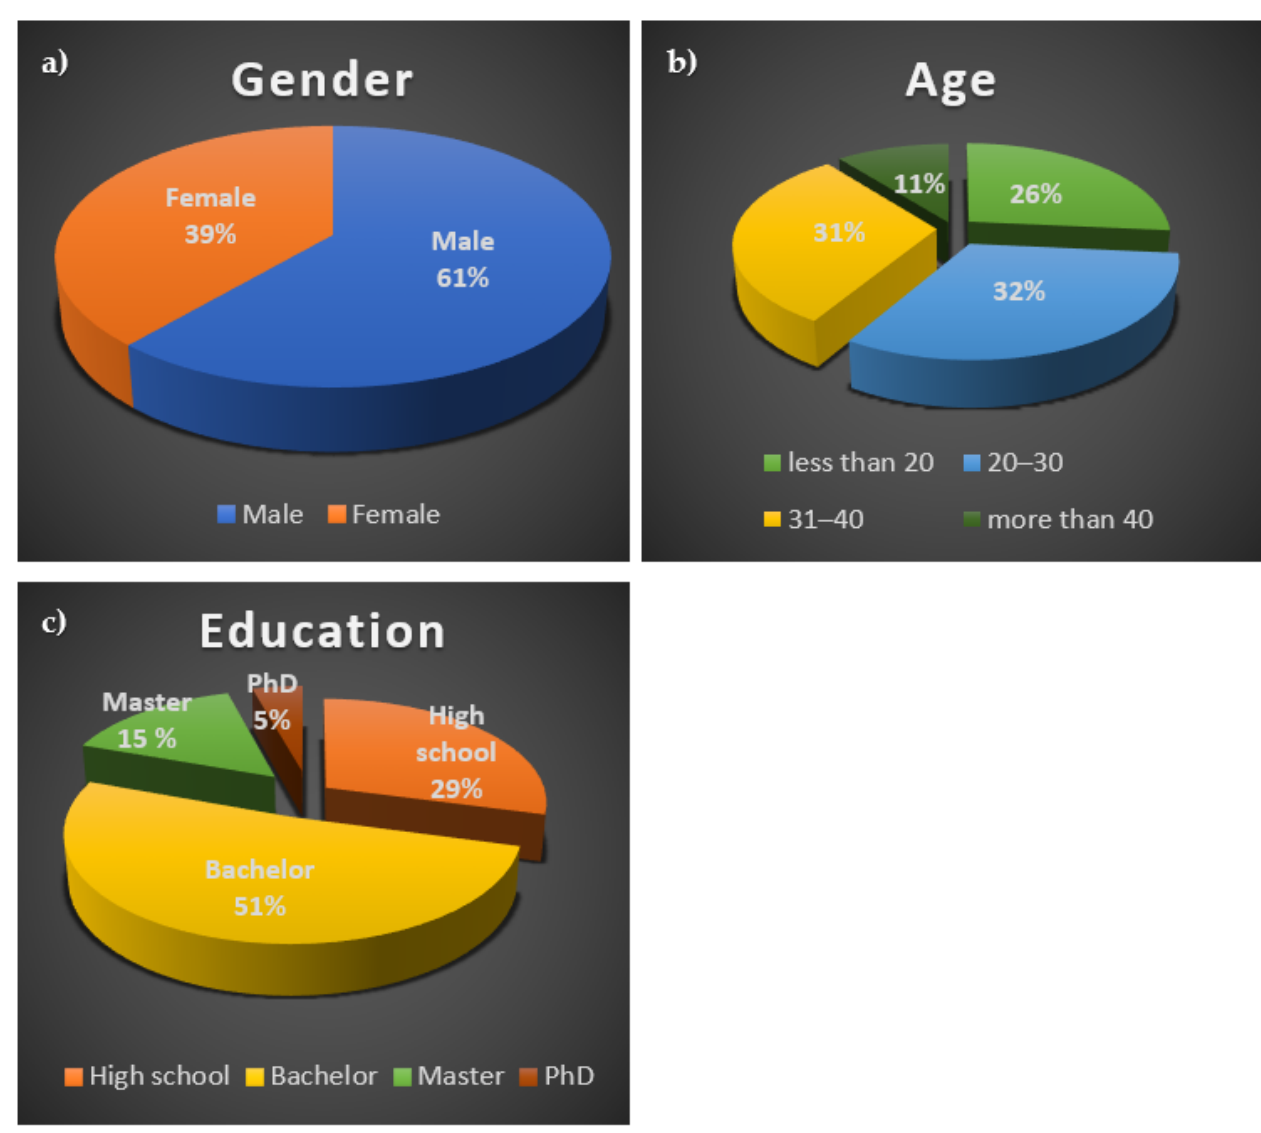
Figure 7. Demography: ( a ) gender; ( b ) age; ( c ) education.